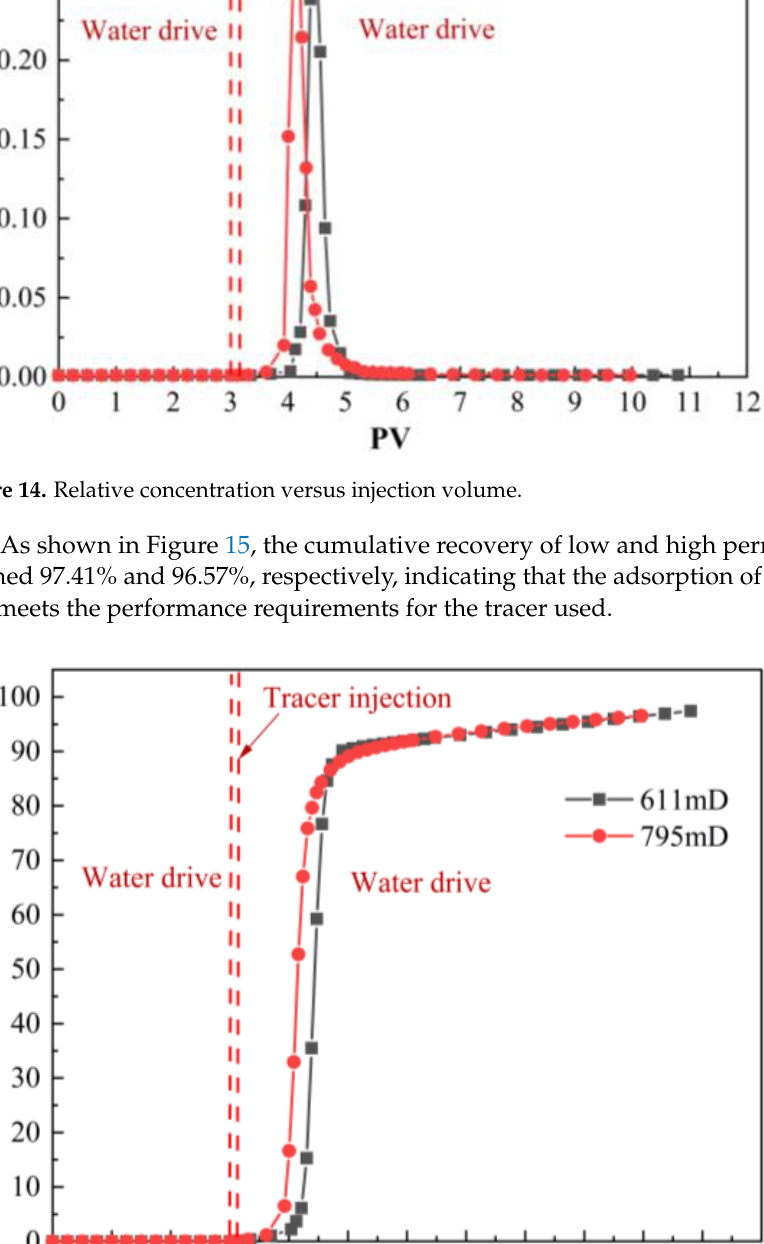
Figure 16. Relationship between shunt ratio and injection volume. 4. Conclusions The surface of CQD-W is rich in polycarboxyl and siloxy groups with good water solubility, and CQD-W shows negative electrical properties in pure water; this makes CQD-W adsorption on the rock surface very low. The particle size characterization results show that the average particle size of CQD-Ws is 2 nm; this can meet the reservoir mobility and injectivity with permeability above 0.005 mD. (1)